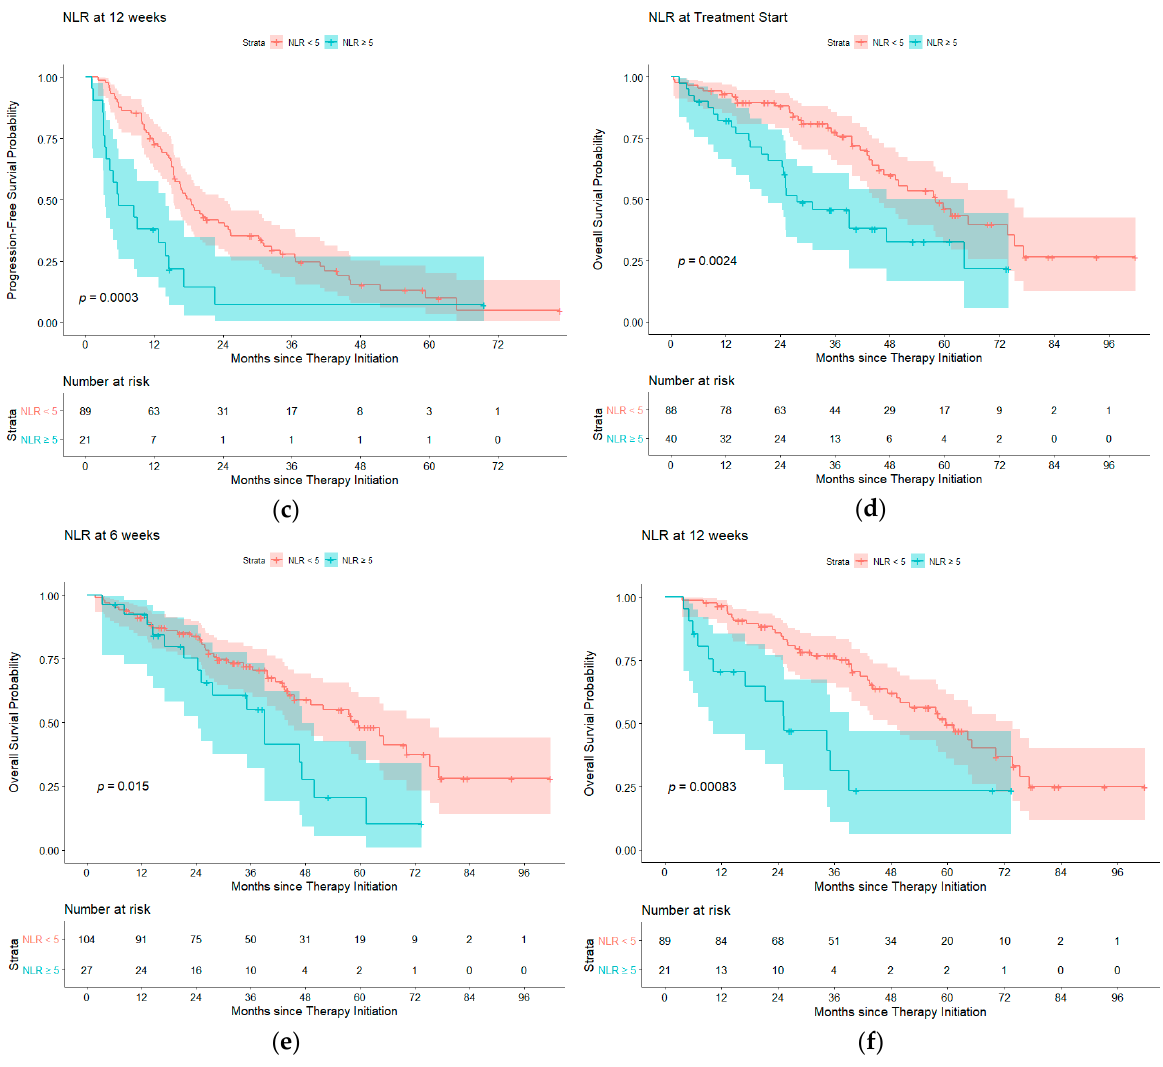
Figure 1. Progression free survival probability for NLR < 5 (blue) compared to NLR ≥ 5 (red) at ( a ) treatment start, ( b ) 6 weeks of therapy and ( c ) 12 weeks of therapy. Overall survival probability for NLR < 5 compared to NLR ≥ 5 at ( d ) treatment start, ( e ) 6 weeks of therapy and ( f ) 12 weeks of therapy. Abbreviations: NLR, neutrophil ‐ to ‐ lymphocyte ratio.